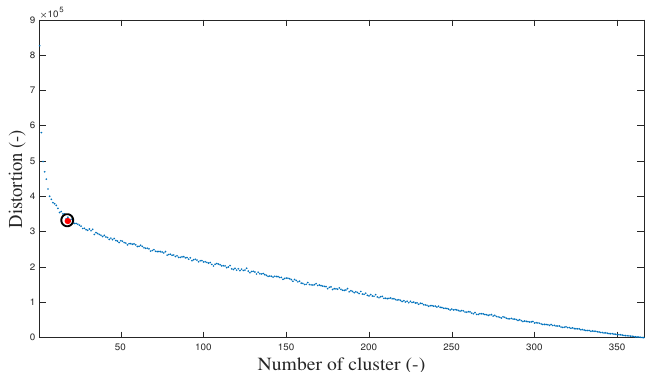
Figure 3. Data set of load demand.